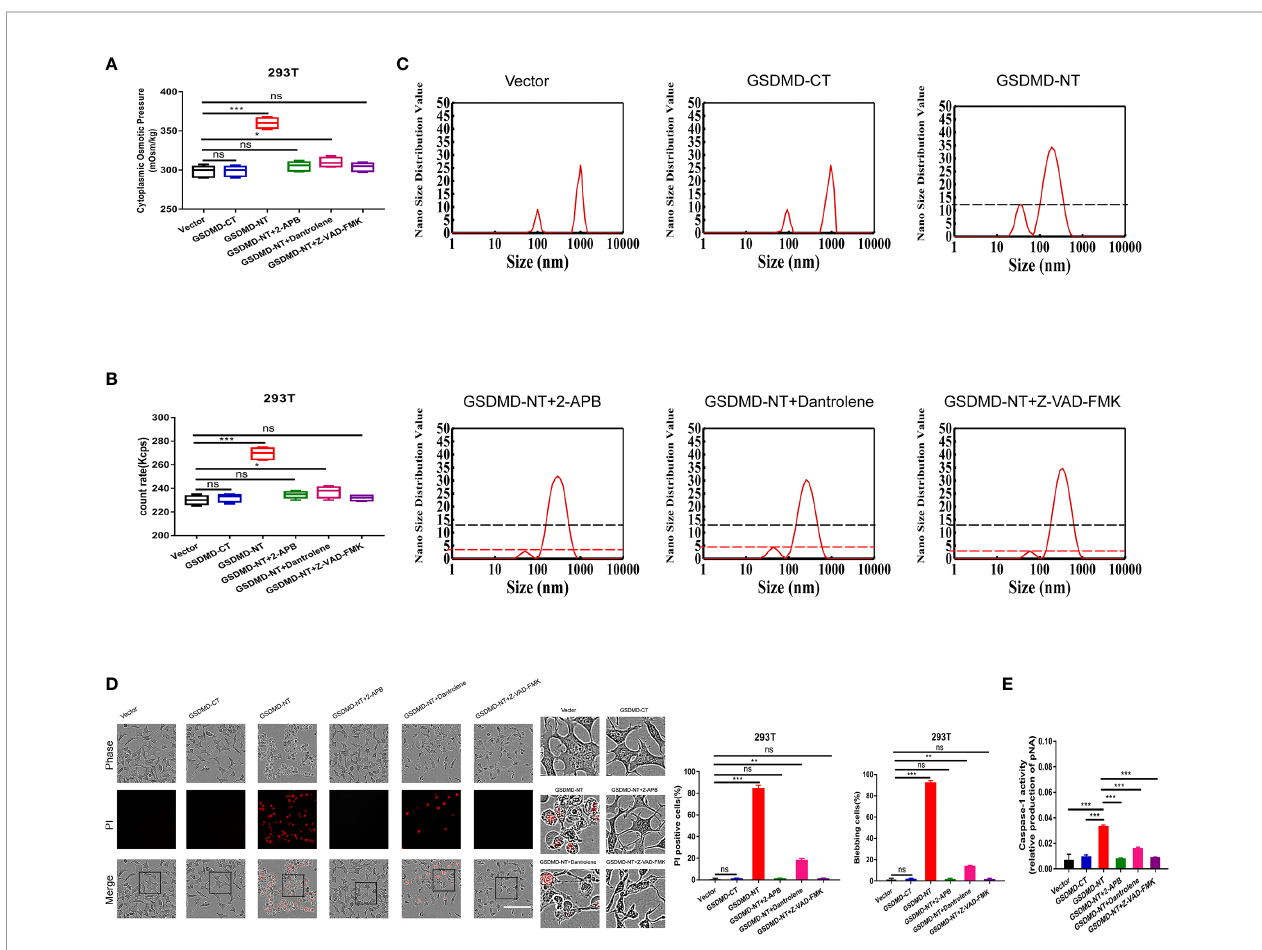
FIGURE 7 | GSDMD-NT induced blebbing and permeabilization, regulated by Ca 2+ and caspase-1 activation. (A) 293T cells were transfected individually with the vector control, GSDMD-CT, and GSDMD-NT. The cytoplasmic OP values of U87 cells were measured using a freezing point osmometer under the above stimuli. (B) The count rate of PNs in U87 cells. (C) Nano size distribution value of protein granules in the cytoplasm. (D) Representative time-lapse images of U87 cells under the different treatments. Cell membrane integrity was monitored by PI uptake (red fl uorescence). The bar charts represent the percentage of cells showing PI positivity and blebbing. (E) Caspase-1 activity of cells. Mean of ≥ 3 experiments ± SEM. Values marked with asterisks are signi fi cantly different, as determined using a t -test. ns, not signi fi